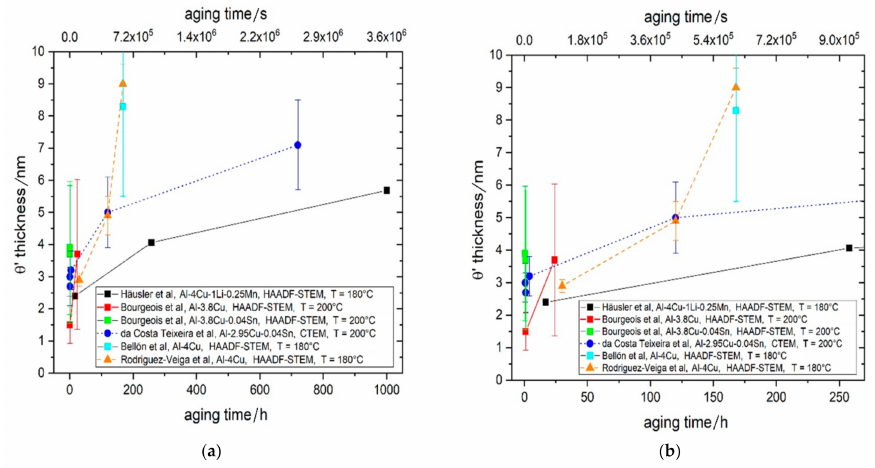
Figure 3. Experimental θ (cid:48) thickness data (Häusler et al., Ref [58]) compared to different literature sources (da Costa Teixeira et al., Ref [17], Bourgeois et al., Ref [60], Bell ó n et al., Ref [62], Rodr í guez- Veiga et al., Ref [63]) ( a ) up to 1000 h, ( b ) up to 258 h.